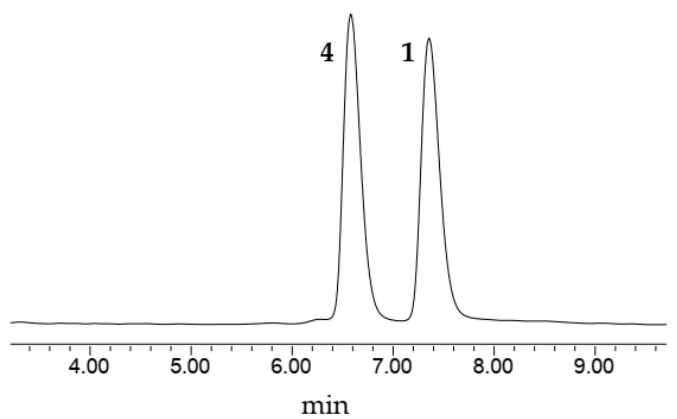
Figure 2. 1 H- 1 H COSY ( blue line ) and key HMBC ( → ) correlations of compound 1 – 3 .